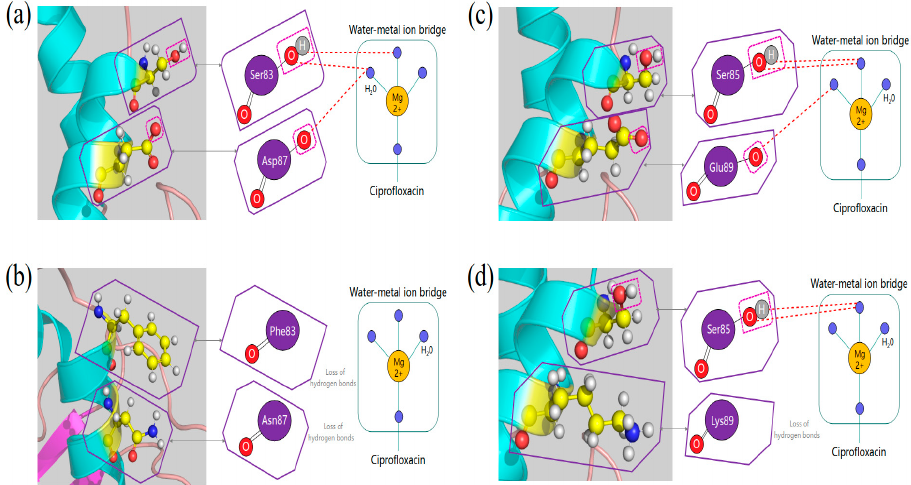
Figure 6. Structural comparison of GyrA S83F/D87N and ParC E89K mutation between wild and mutant strains. ( a ) Quinolone and gyrase binding in the wild-type strain is facilitated by a water- metal ion bridge, which forms hydrogen bonds between the water molecules and Ser 83/Asp87 amino acid. ( b ) Hydrogen bonds are missing in the mutant APP strain, decreasing the binding af- finity of quinolone. ( c ) Quinolone and topoisomerase IV binding in the wild-type strain occurs through a water-metal ion bridge, where forms a hydrogen bond between the quinolone and Ser 85/Glu89 amino acid that act as anchor points to enzyme. ( d ) Hydrogen bond link with 89 amino acid is missing, weakening the binding affinity of quinolone. 2.7. Plasmid The results of plasmid assembly and annotation of strain SC1810 showed that the strain did not carry the plasmid-mediated quinolone resistance gene (PMQR), which is consistent with the results of PCR amplification.